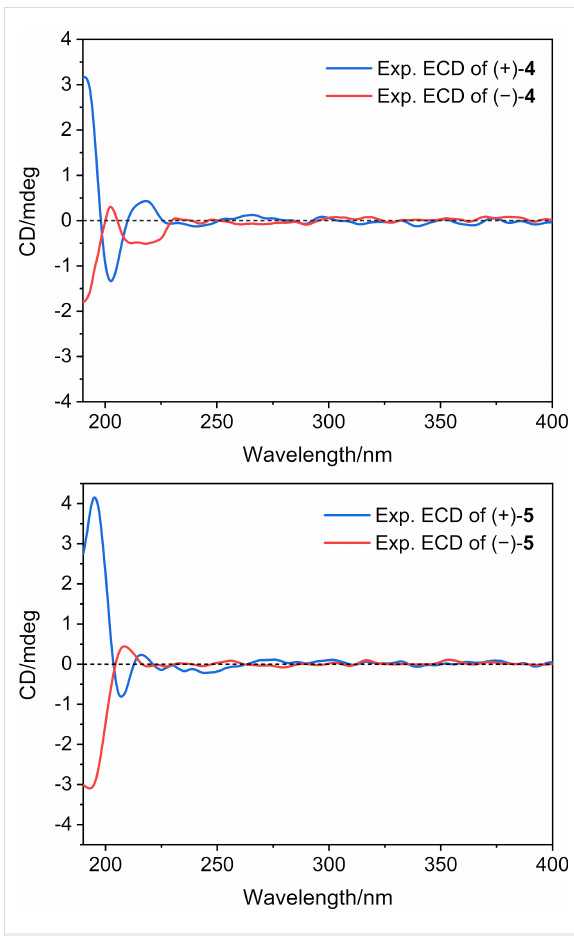
Figure 5: Experimental ECD curves of compounds (+)- 4 , ( − )- 4 (top), (+)- 5 , and ( − )- 5